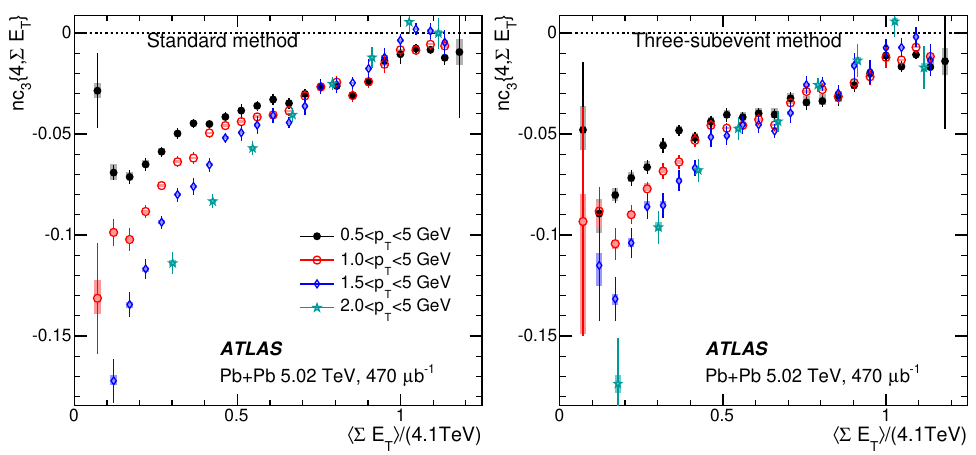
Figure 26 . The nc 3 f 4 g values calculated for charged particles in several p T ranges with the standard cumulant method (left) and three-subevent method (right). The error bars and shaded boxes represent the statistical and systematic uncertainties, respectively. Zero is indicated by a dotted line.